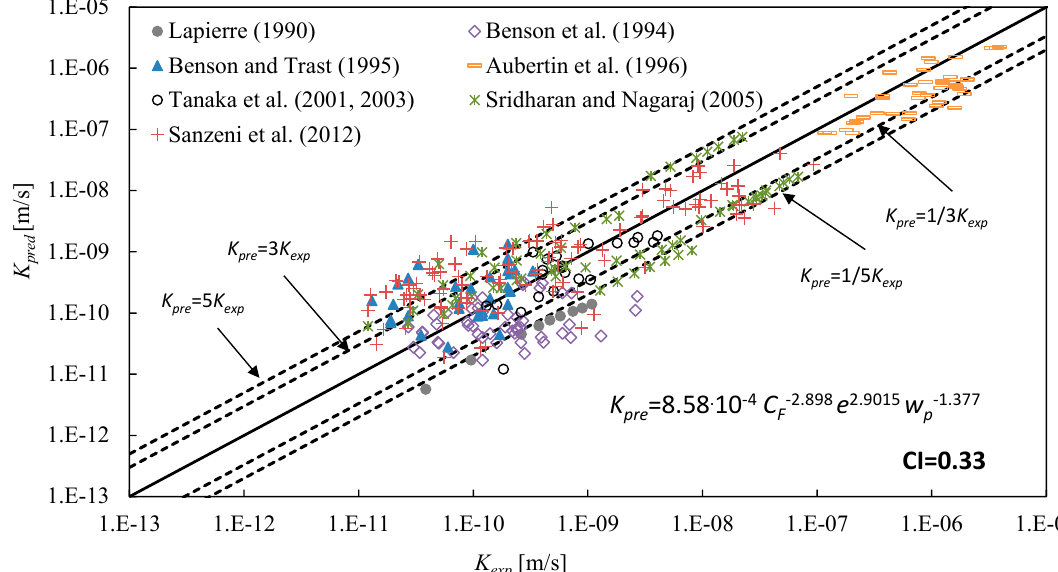
Figure 2. Experimental ( K exp ) and predicted value ( K pre ) of the saturated hydraulic conductivity as determined by Equation (19).